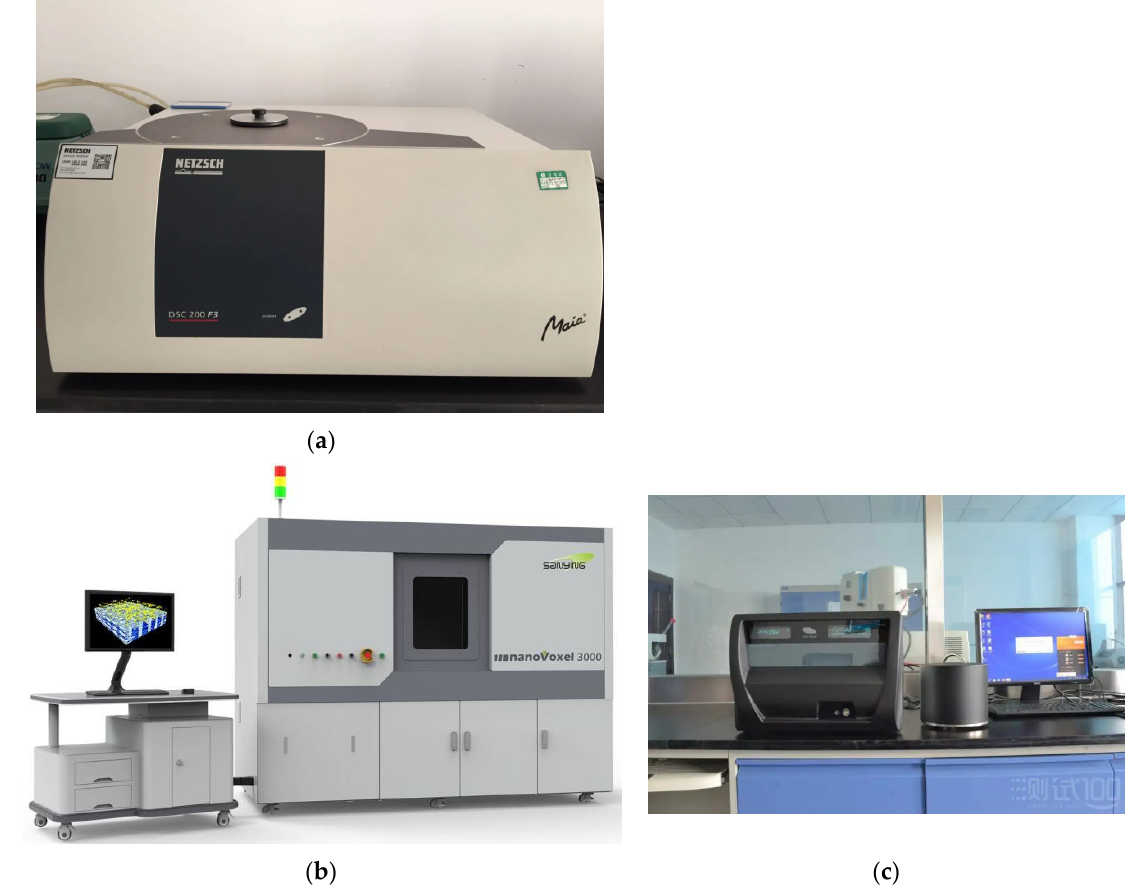
Figure 5. Experimental equipment [34]. ( a ) Differential scanning calorimeter; ( b ) NanoVoxel-3502E CT scanner; ( c ) hot disk thermal constant analyzer. (Wang et al. 2018).